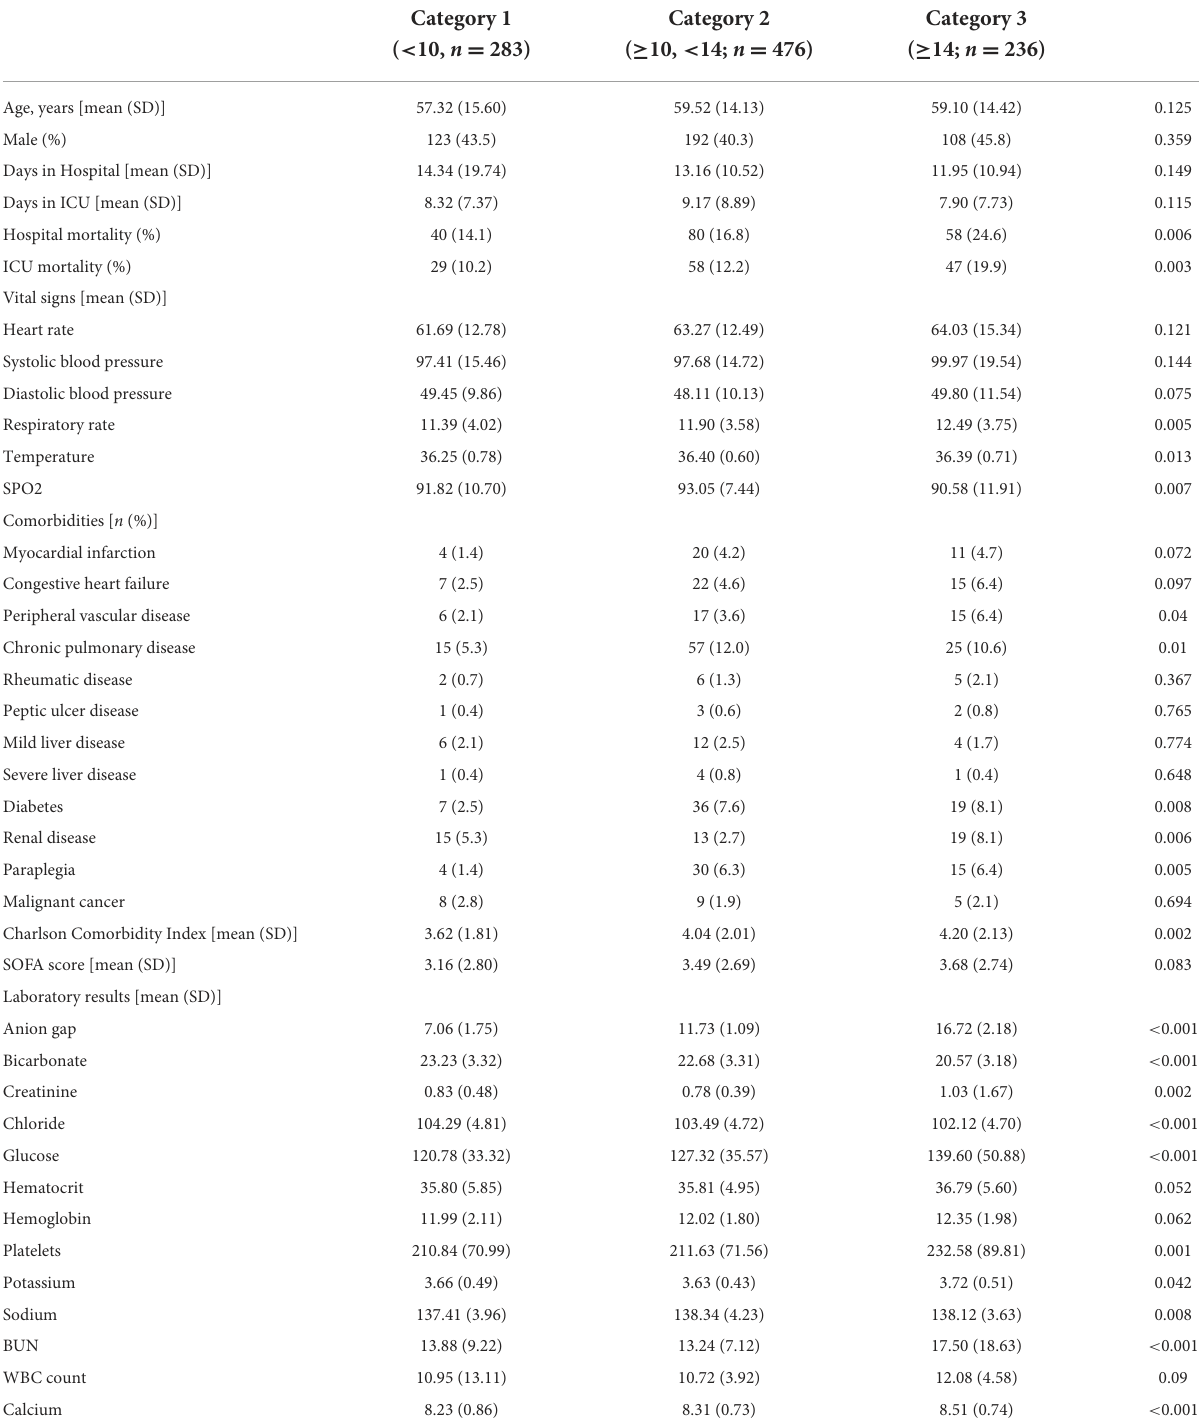
TABLE 1 Patient characteristics by anion gap concentration